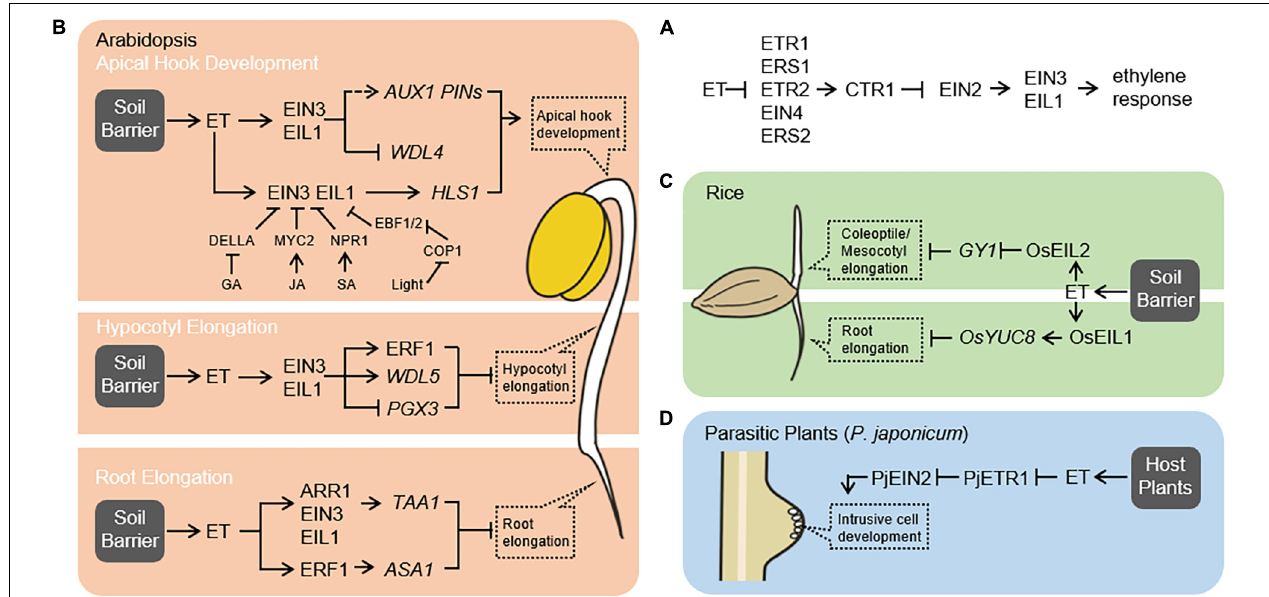
FIGURE 1 | Ethylene signaling regulates the growth and development of plants encountering physical barriers. (A) The linear model of the ethylene signaling pathway in Arabidopsis . Ethylene signaling involves ethylene receptors [ethylene response 1 (ETR1), ethylene response sensor 1 (ERS1), ETR2, ethylene insensitive 4 (EIN4), and ERS2], the negative regulator [constitutive triple response 1 (CTR1)], the central mediator (EIN2), and the master transcription factors [EIN3/EIN3-like 1 (EIL1)]. The linear ethylene signaling pathway is conserved between rice and Arabidopsis (Yang et al., 2015a). (B) Ethylene facilitates Arabidopsis adaption to soil barriers. Ethylene regulates apical hook development by two different pathways. On the one hand, ethylene reinforces asymmetric auxin distribution within the apical hypocotyl by inducing the expression of AUX1 and PIN s, and by repressing the expression of WDL4 that influences PIN protein trafficking (Vandenbussche et al., 2010; Zádníková et al., 2010; Deng et al., 2021). On the other hand, ethylene regulates differential growth of apical hypocotyl through EIN3/EIL1 transcriptional regulation of HLS1 expression (Shen et al., 2016). Other endogenous phytohormones including gibberellic acid, jasmonic acid, and salicylic acid and light signal also modulate ethylene-regulated apical hook development by influencing the EIN3/EIL1- HLS1 module (An et al., 2012; Zhang et al., 2014; Shi et al., 2016a; Huang et al., 2020). Ethylene inhibits hypocotyl elongation by activation of ERF1 pathway, upregulation of WDL5 expression, and downregulation of PGX3 expression via EIN3-dependent signaling pathway (Zhong et al., 2014; Sun et al., 2015; Wu et al., 2020). Ethylene inhibits root elongation by induction of auxin biosynthesis through upregulating WEI8/TAA1 and ASA1 expression in EIN3- and ARR1-dependent and ERF1-dependent manner, respectively (Stepanova et al., 2005, 2008; Mao et al., 2016; Yan et al., 2017). (C) Ethylene facilitates rice adaption to soil barriers. In monocot rice seedlings, ethylene promotes both coleoptile and mesocotyl elongation by repression of GY1 expression via OsEIL2-dependent signaling pathway (Xiong et al., 2017). Ethylene inhibits root growth by promoting auxin biosynthesis